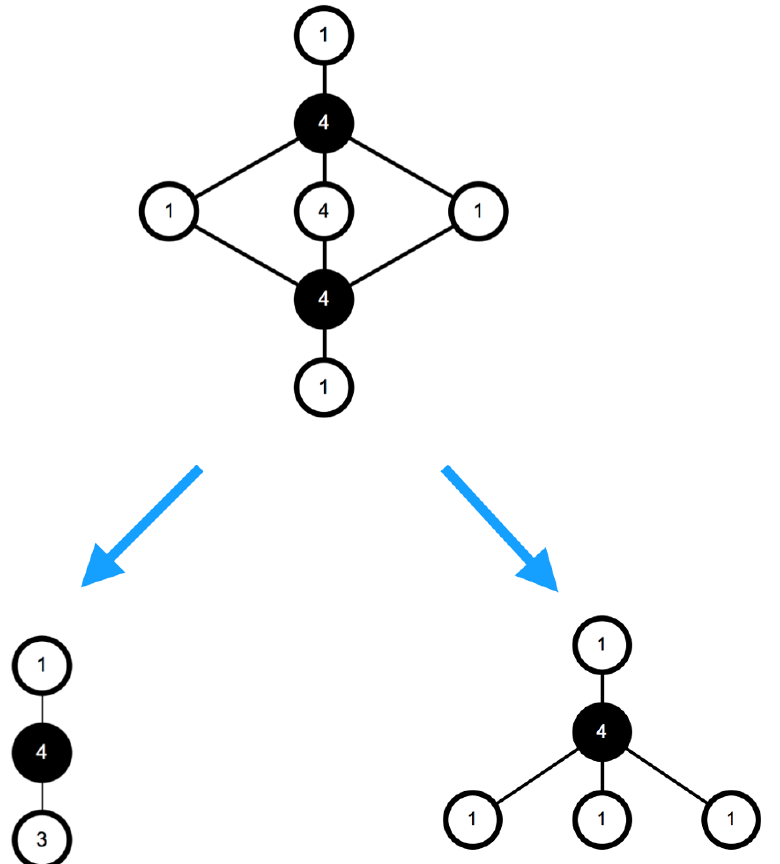
Figure 4 . From 4D, N = 1 reducible adinkra to irreducible adinkras (vector and chiral supermul-